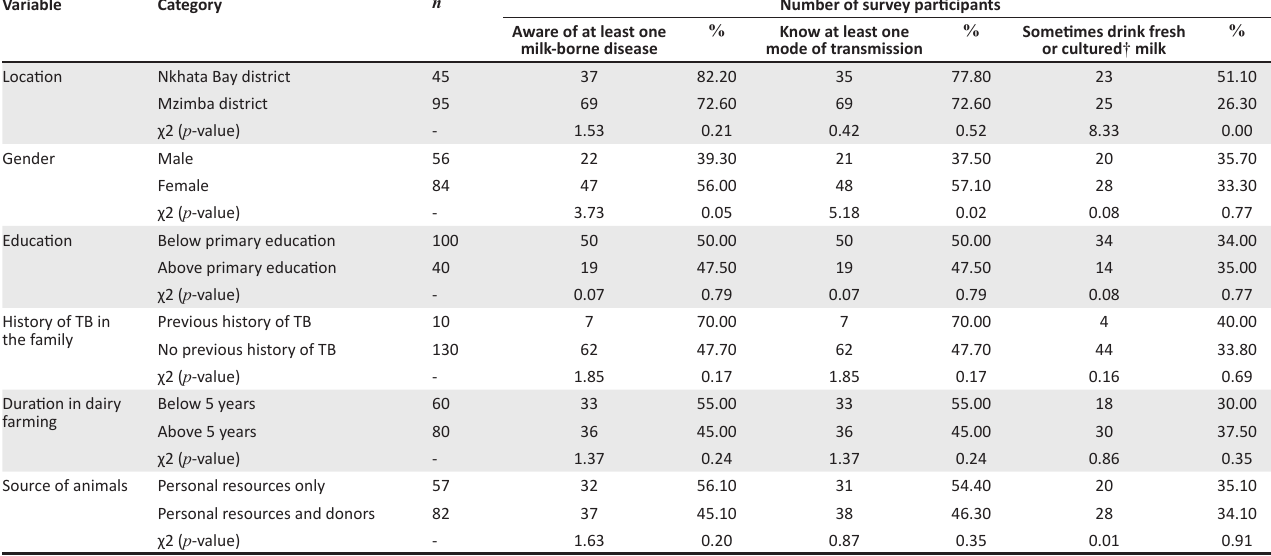
TABLE 2: Association of some smallholder dairy farmer characteristics, milk-borne disease awareness and milk consumption habits. Variable